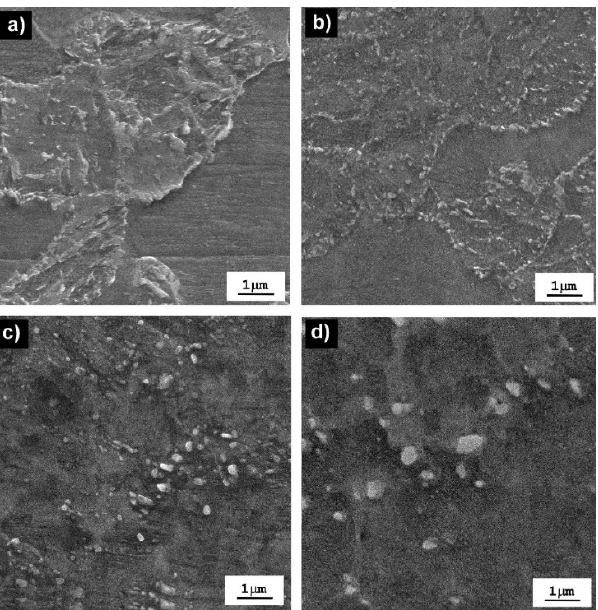
Figure 3. Microstructure of the slow-heated and isothermally tempered DP980 steel for 3600 s at the various peak temperatures: ( a ) 400 °C, ( b ) 500 °C, ( c ) 600 °C and, ( d ) 700 °C. ( α = ferrite, α ’R = tempered martensite).